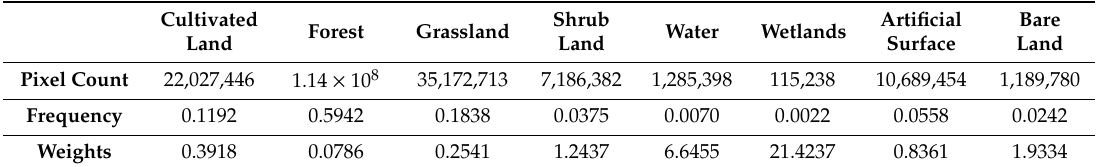
Table 2. Pixel numbers for each class and the computed median frequency class weights used in DeepLabV3 + training (Slovenia